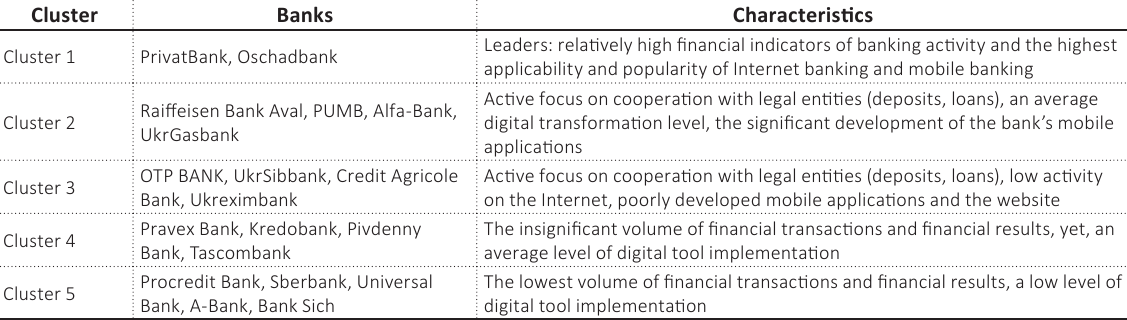
Table 5. Dependence of the competitive position by certain financial indicators of banks’ activity on the competitive level of digital transformation ( x )